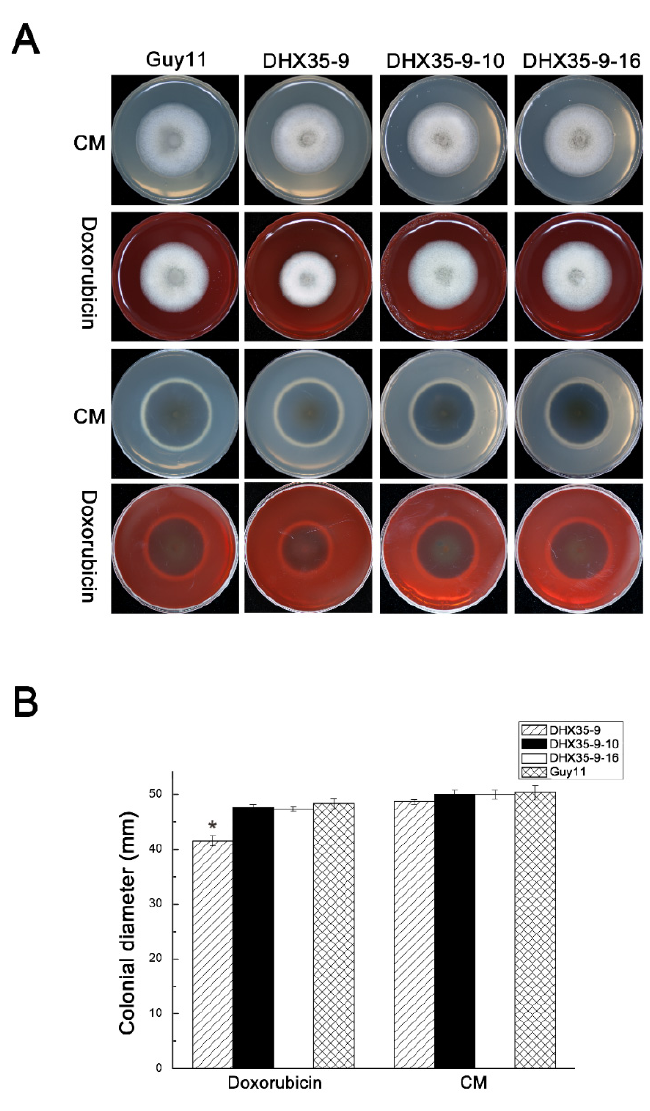
Figure 5. MoDHX35 mutant is hypersensitive to doxorubicin. ( A ) The strains were cultured on CM supplemented with 75 µ g/mL doxorubicin for 6 d. ( B ) The colonial diameters were measured and the relative inhibition rates compared. Standard deviations are indicated by the error bars. The asterisks indicate significant differences at p < 0.05 level.